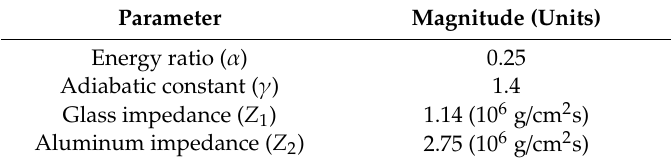
Table 2. Parameter values used in plasma pressure modeling [37,42], with permission from ASME, 2019.